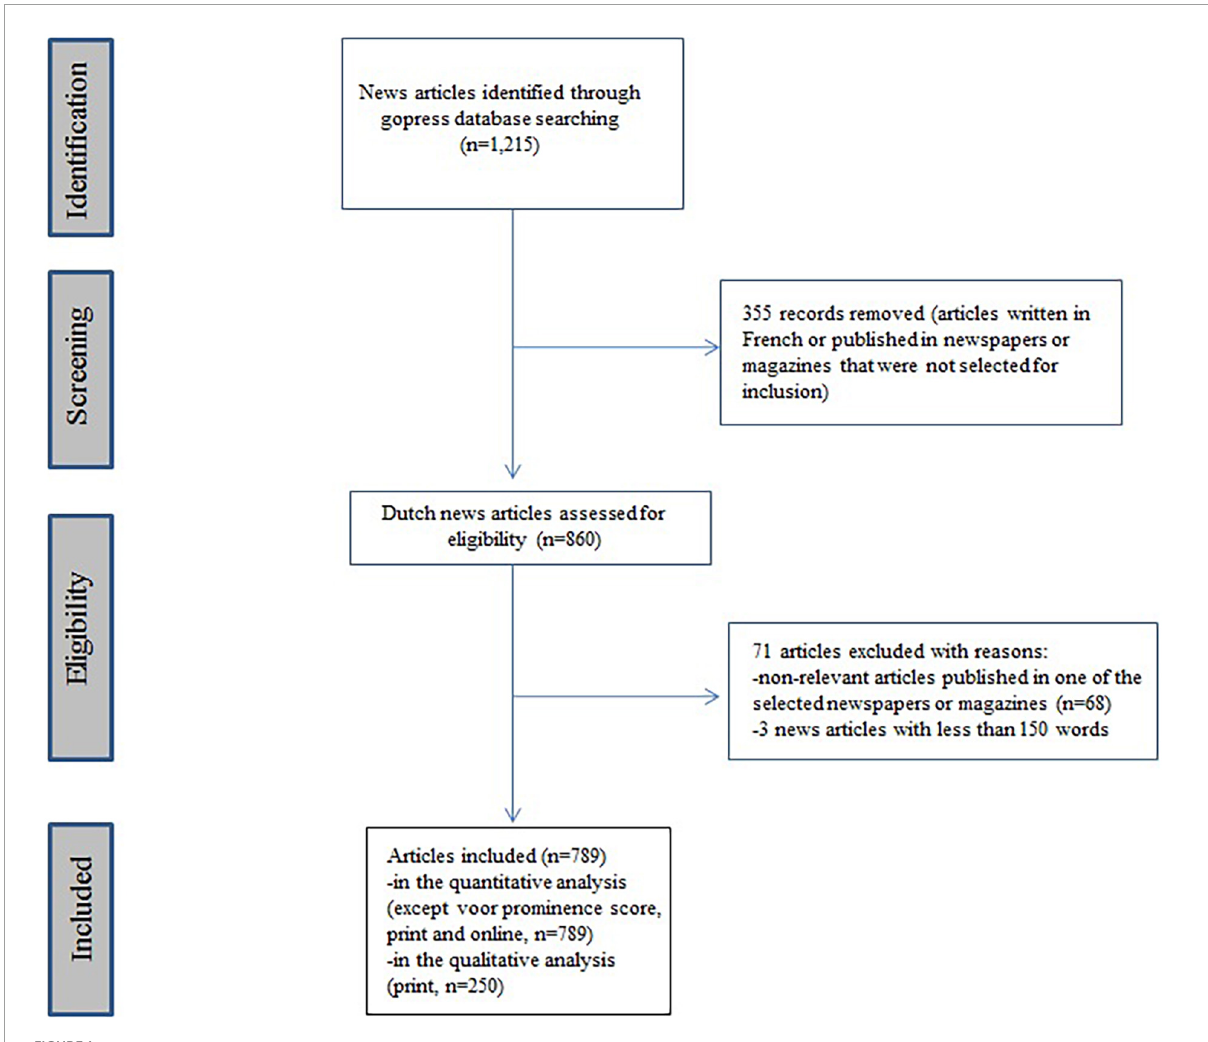
FIGURE1 Flowchart of literature